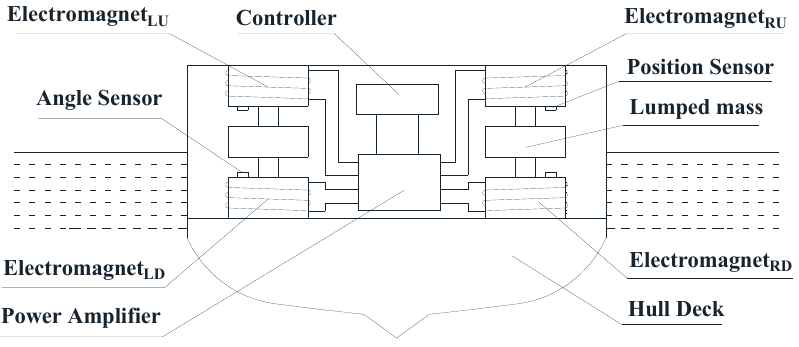
Figure 1. Structural diagram of EMS inertial stabilizer.